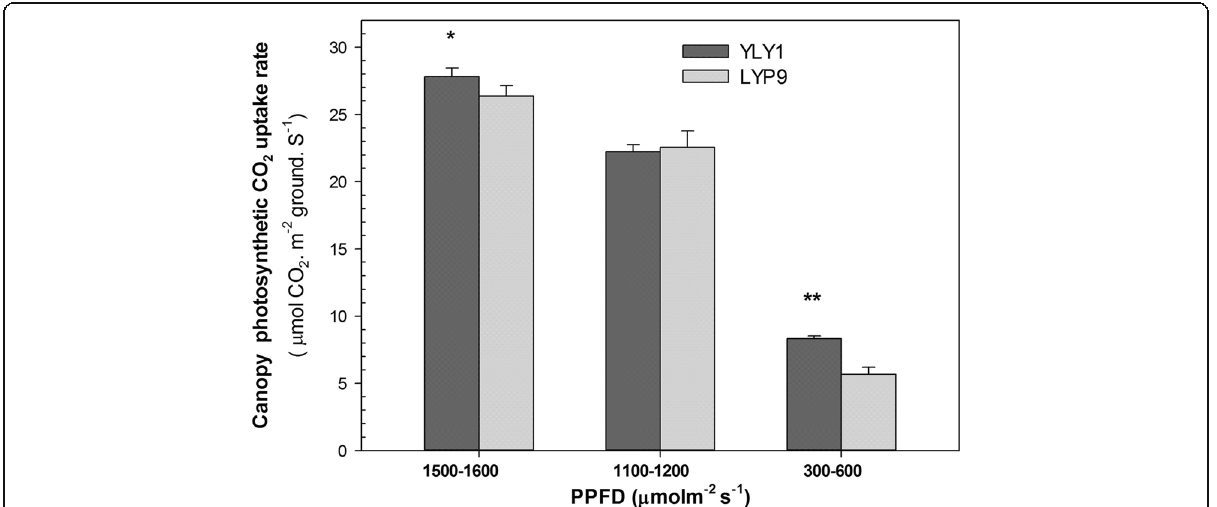
Fig. 3 Canopy photosynthesis measured using the canopy photosynthesis and transpiration system (Song et al. 2016) at the grain filling stage in